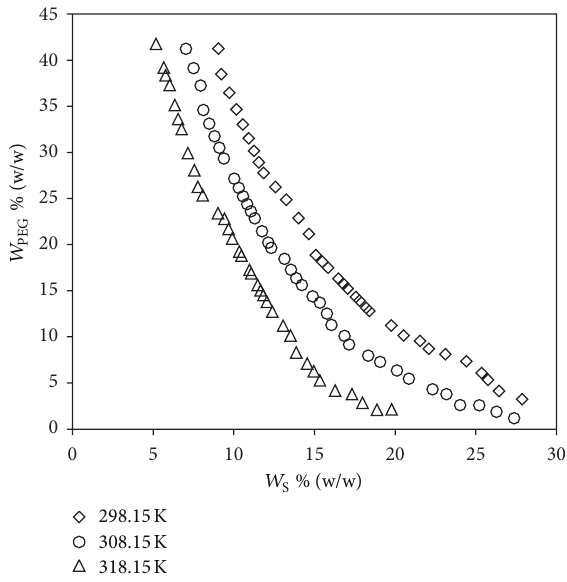
Figure 1: Effect of the temperature on the location of binodal curves ) + sodium succinate ( 𝑊 for the PEG 6000 ( 𝑊 PEG